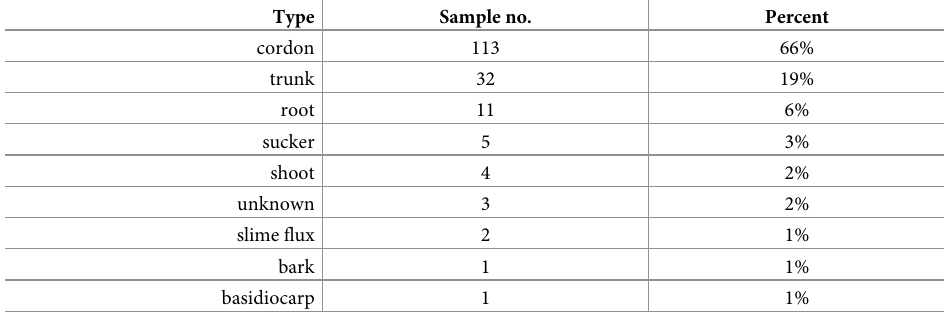
Table 1. Type of samples collected from the Northern Midwest in 2019. The majority of the 172 samples included woody sections of cordon, trunk, root, sucker, shoots, and unknown.